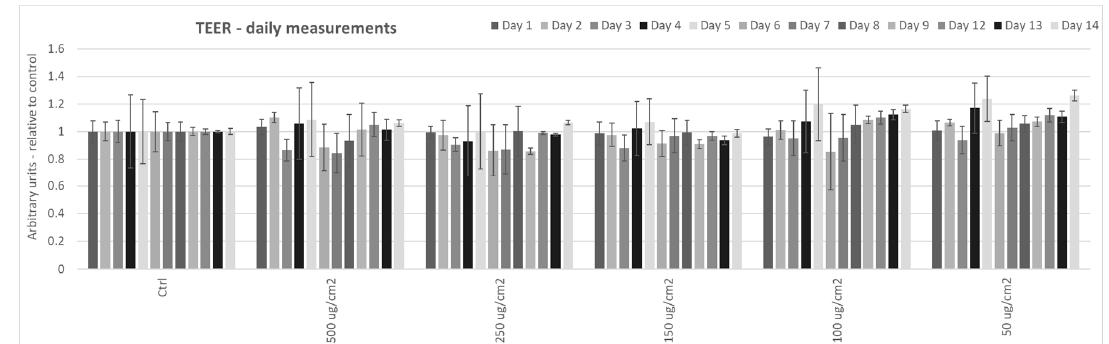
Figure 1. Effects of particulate matter exposure on the transepithelial electrical resistance (TEER) of 3D human intestinal tissues. TEER was analyzed in 3D human intestinal tissues that were exposed to particulate matter after 24 h at the following doses: 50, 100, 150, 250, and 500 µg/cm 2 daily for two weeks. Data are expressed as arbitrary units (averages ± SEM of two experiments, * p < 0.05).